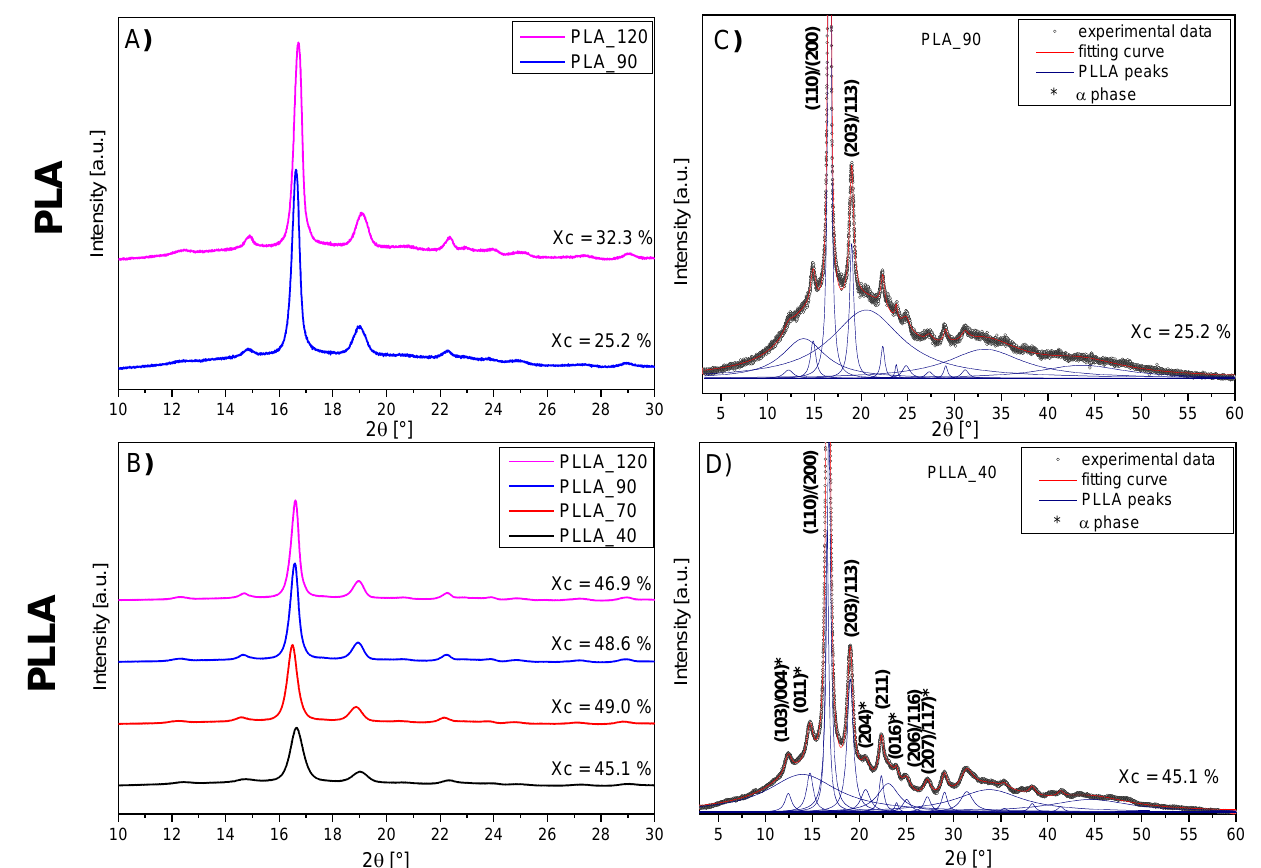
Figure 7. Diffraction curves of the PLA ( A ) and PLLA ( B ) microspheres conditioned at temperatures of 40, 70, 90, and 120 ◦ C. ( C , D ) the exemplary deconvolution of curves, respectively of the PLA_90 and PLLA_40.The diffraction peaks marked with asterisks in the graphs A ‘and B’ are characteristic only for the α phase. The others can be connected with both α and α ‘.